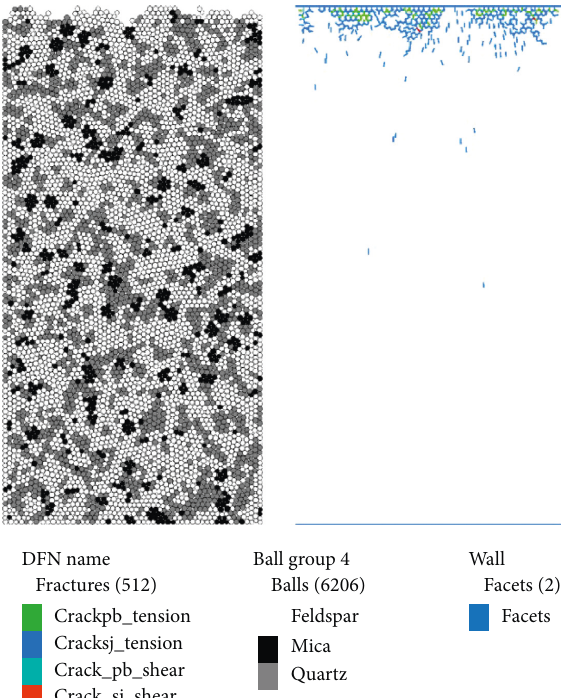
Figure 14: The crack development of rock model under ultrasonic high-frequency